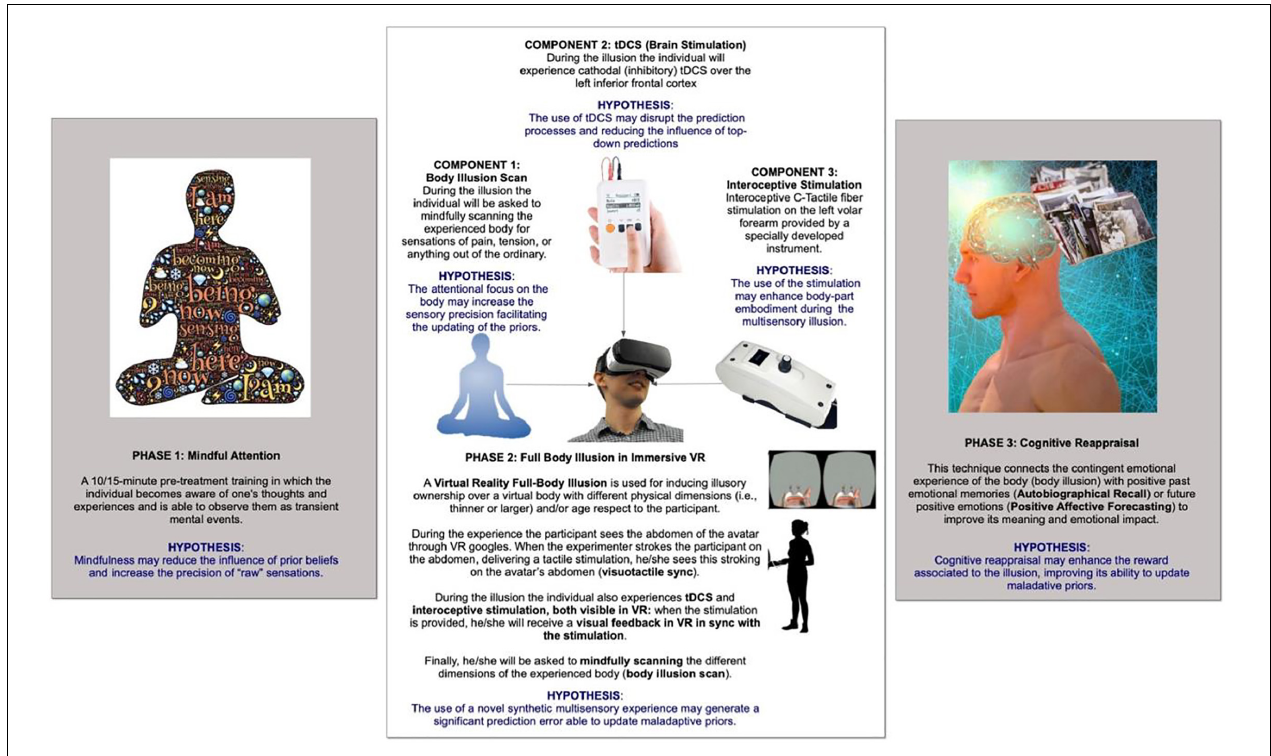
FIGURE 2 | Regenerative virtual